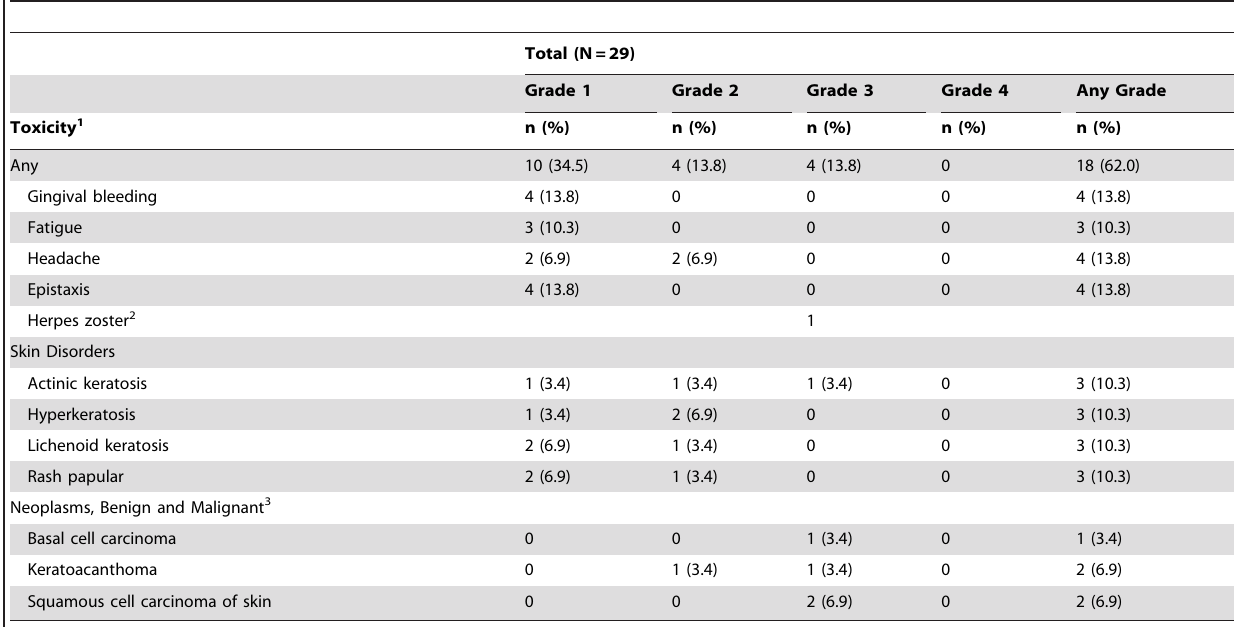
Table 2. Summary of Adverse Events Related to Study Treatment That Occurred in . 2 Patients or Reported As CTCAE Grade 3 or